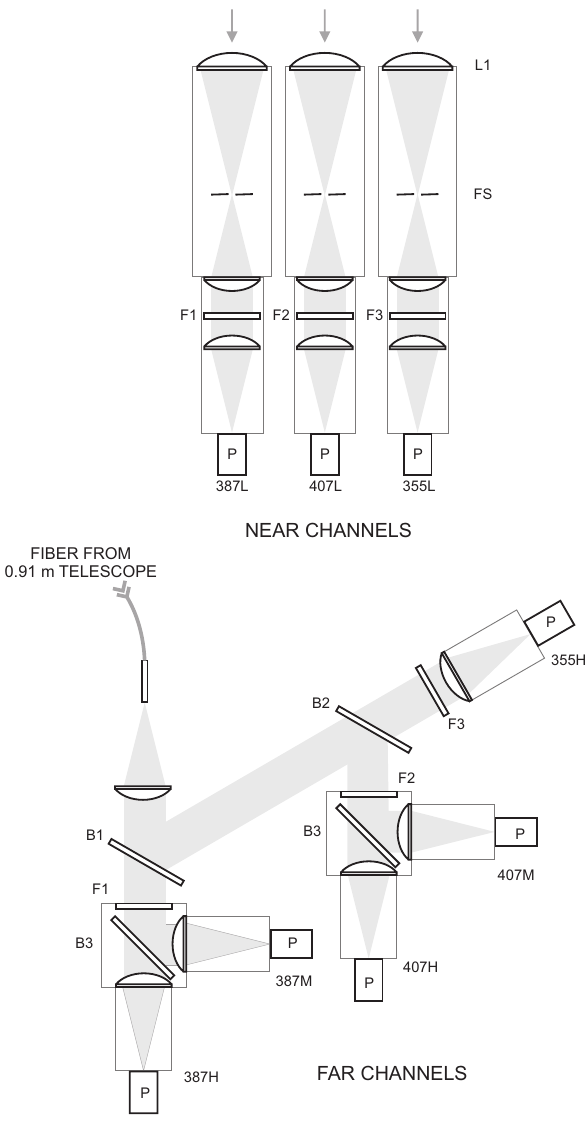
Fig. 1. TMW lidar receiver initial configuration, i.e., 2005–2007 for the five high- and mid-intensity channels, and 2005–present for the three low-intensity channels. A fourth low intensity channel, 355nm extra-low intensity, was added in